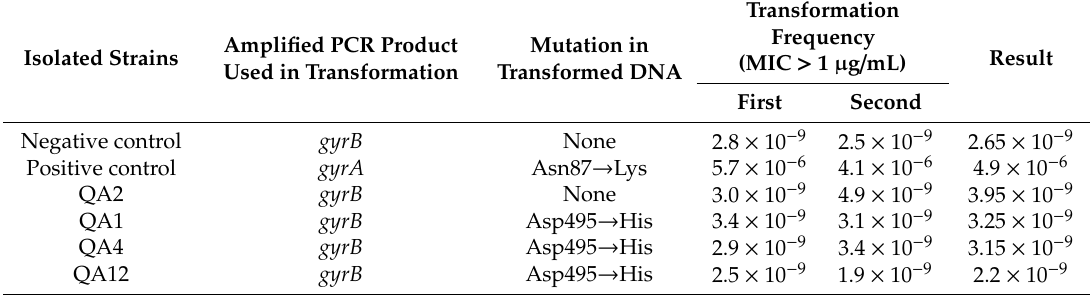
Table 4. Transformation of H. pylori Using PCR-amplified gyrB DNAs (2005 / 2006).